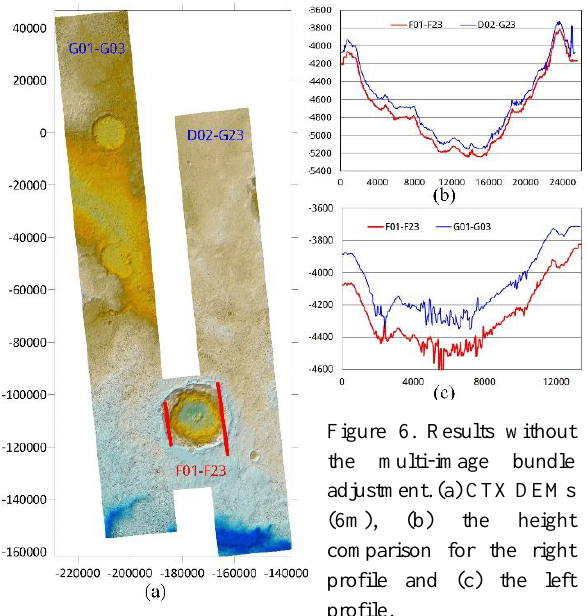
Figure 7. Results after the multi-image bundle the height comparison for the right profile and (c) the left